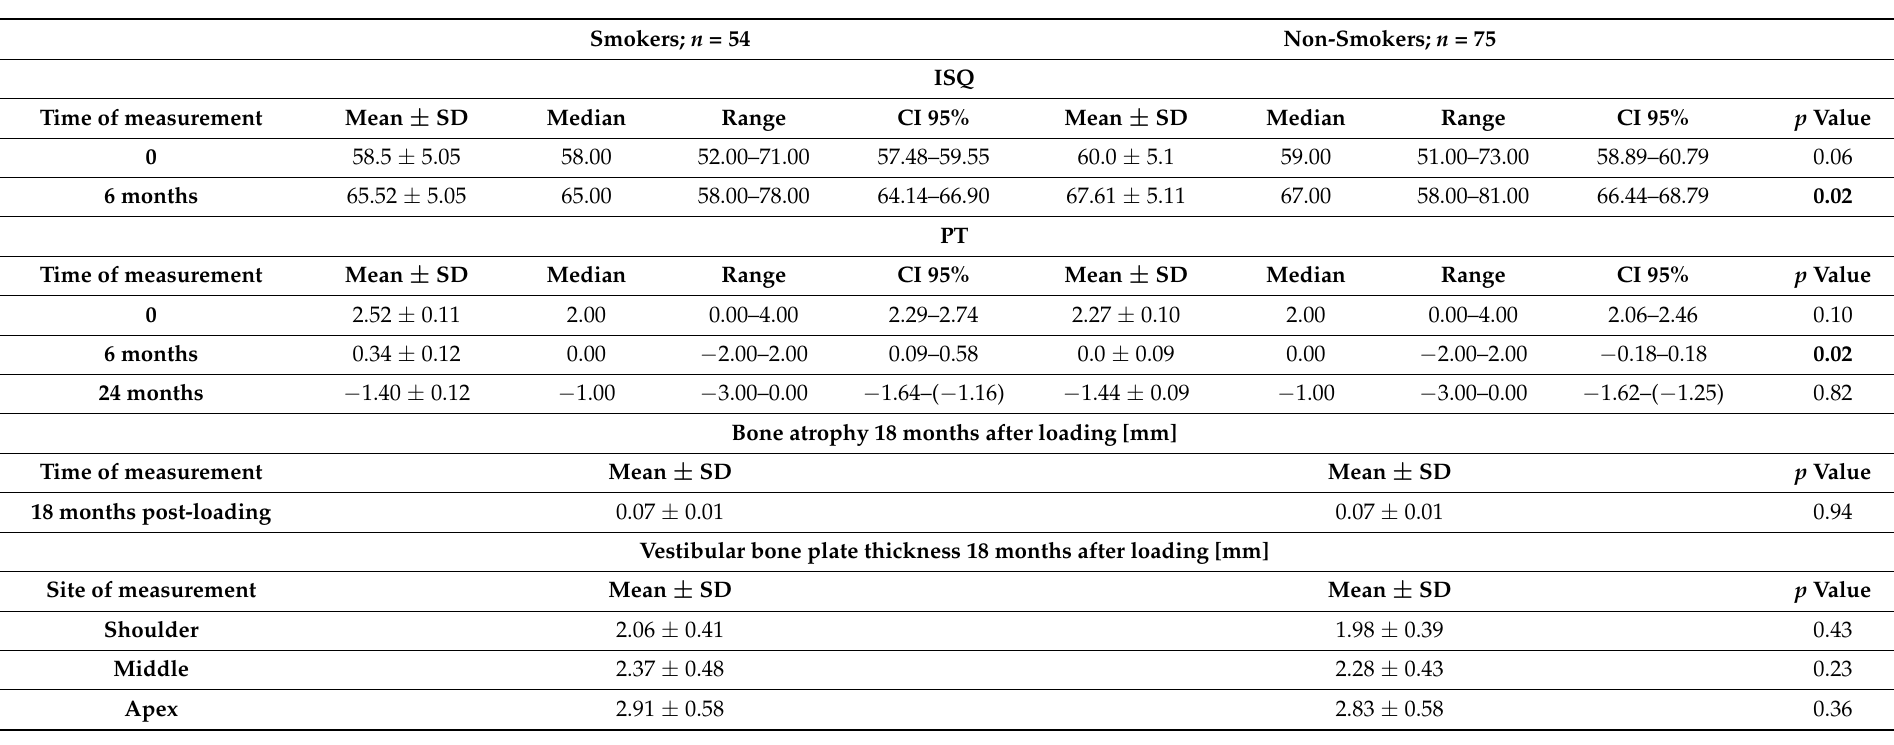
Table 3. Implant stability and bone atrophy in the aesthetic area of smokers and non-smokers, following immediate implantations in maxilla (ISQ—mean Implant Stability Quotient; PT— periotest measurements).